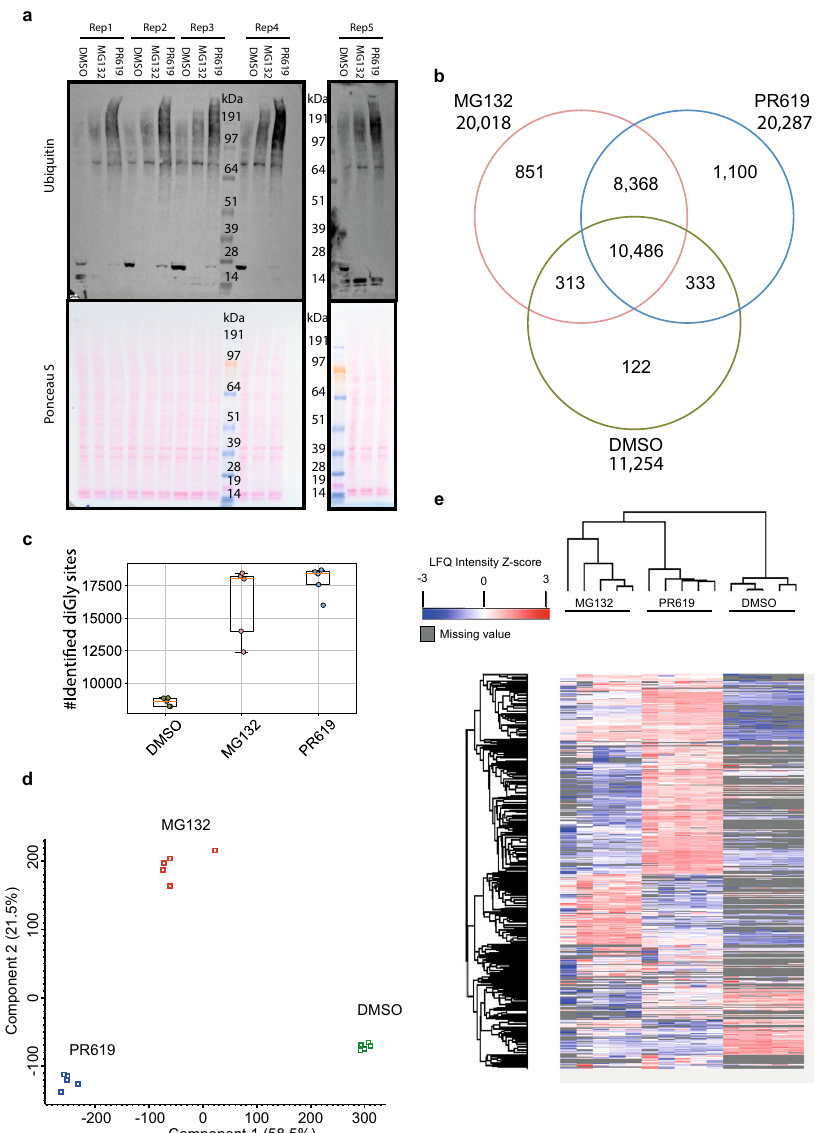
Fig. 4 Data-independent acquisition of Ub sites. a Immunoblots of U2OS input samples treated for 3 h with DMSO, MG132 (10 µ M) or PR619 (20 µ M) and stained for Ub (P4D1), n = 5 biologically independent samples. b DiGly sites were identi fi ed using UbiSite technology in data-independent acquisition (DIA) mode. Data were fi ltered as described in the methods section. Venn diagram of Ub sites identi fi ed per treatment, where sites identi fi ed in at least one replicate in multiple treatments was considered as intersections, n = 5. c Number of diGly sites identi fi ed per treatment, where each data point is represented by a coloured circle, the box contains the 25 – 75 th percentile and the orange line denotes the mean and the error bars represents the SD, n = 5 biologically independent samples. d Principal component analysis of UbiSite DIA data using components with the highest explained variance, n = 5. e Hierarchical clustering by Euclidean distance where each column in the heatmap is a sample and each row is a Ub site (pre-processed with k-means, 300 clusters, 1000 iterations). The Ub site intensity values were normalised by Z score (subtraction of the mean) and missing values are denoted by a grey colour, n = 5. Source data are provided as a Source Data fi